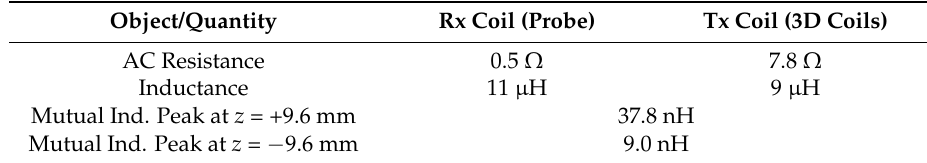
Table 1. Measurement of the maximum inductance of the transmitter.